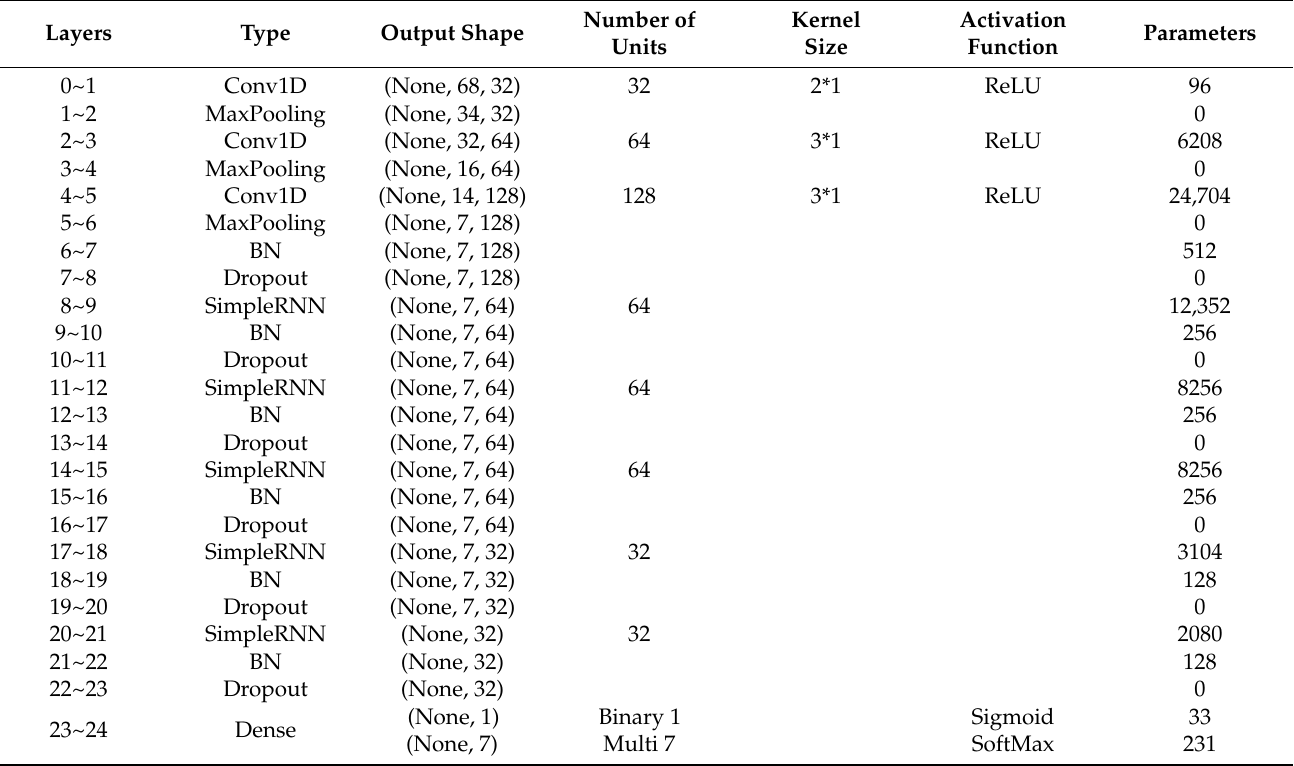
Table 15. CNN + RNN-8-256 (8 layers and 256